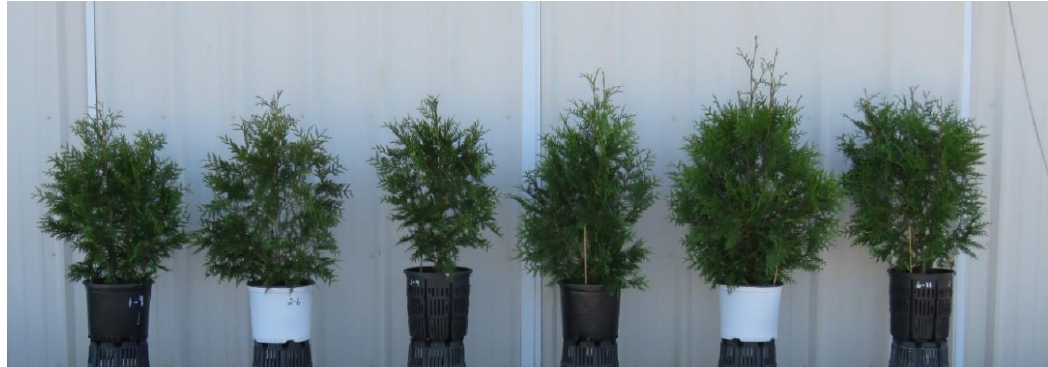
Figure 1. Representative ‘Green Giant’ arborvitae plants 173 days after planting (in Tennessee) in 100% pine bark (three plants on left) and 4 pine bark: 1 peatmoss (v:v; three plants on right) in standard black, standard white, and air pruning containers (left to right within each substrate).